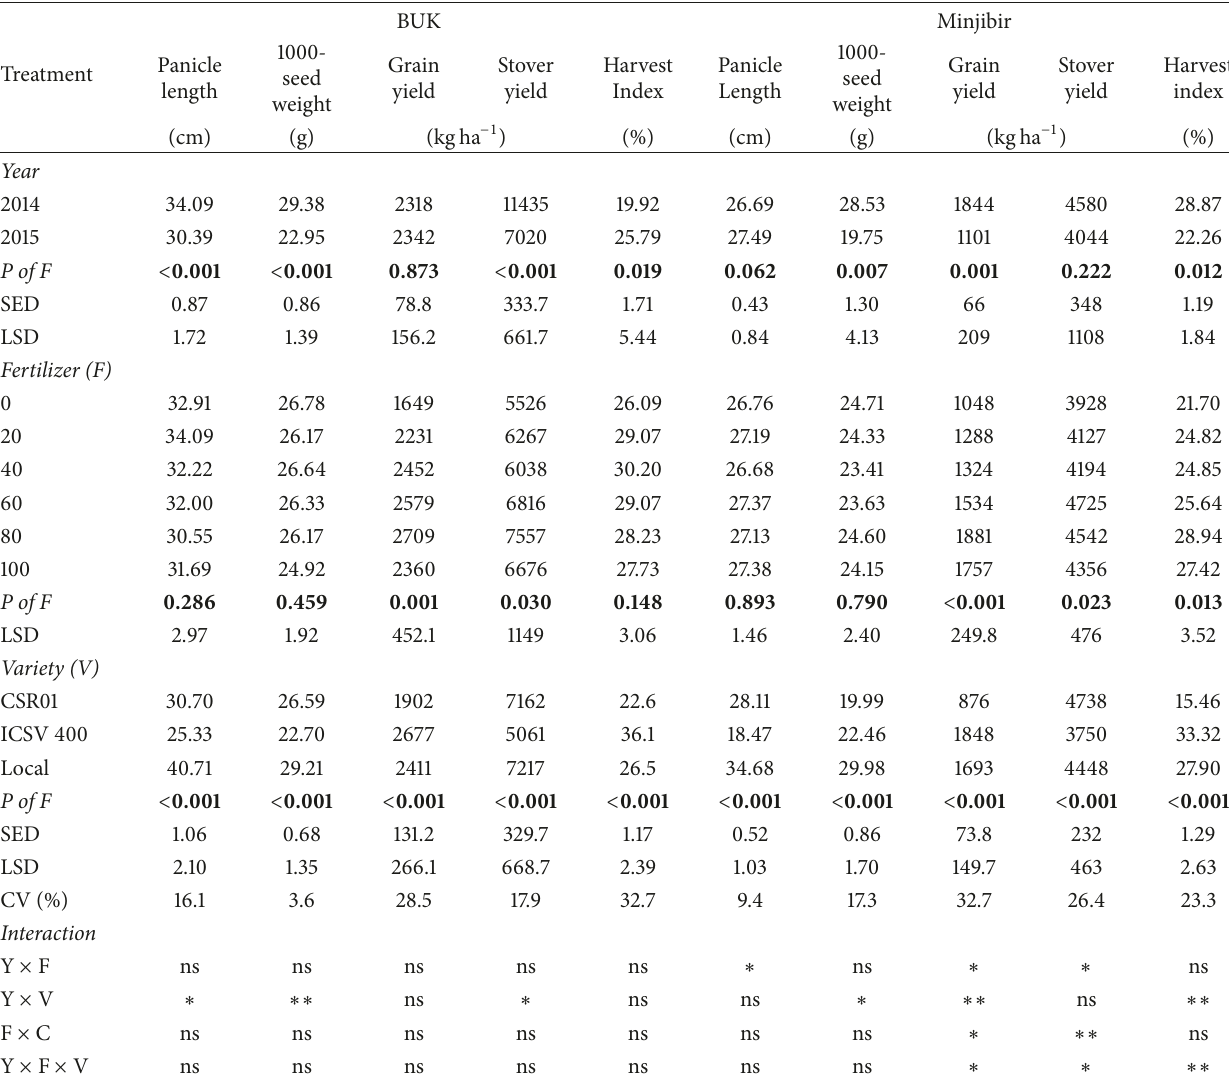
Table 3: Effect of fertilizer levels and variety on panicle length, 1000-seed weight, grain and Stover yields and harvest index of sorghum in Sudan Savanna